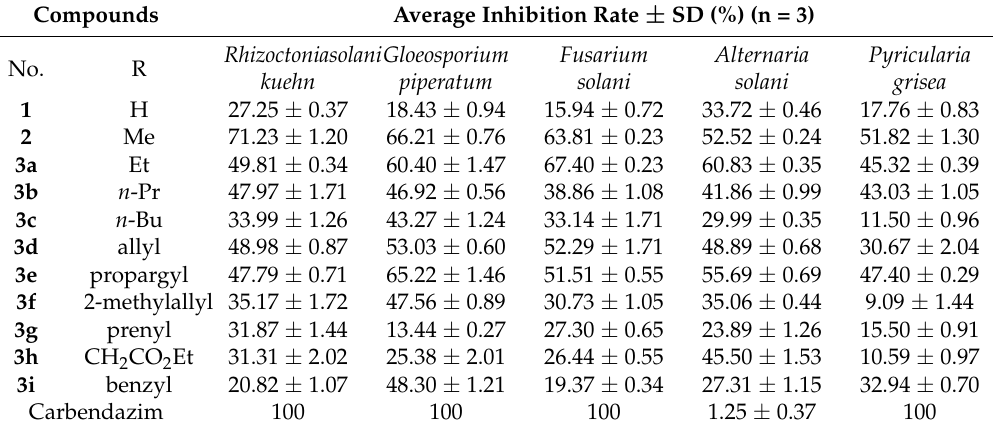
Table 2. Preliminary antifungal activities of all title compounds against another five fungi at 100 µ